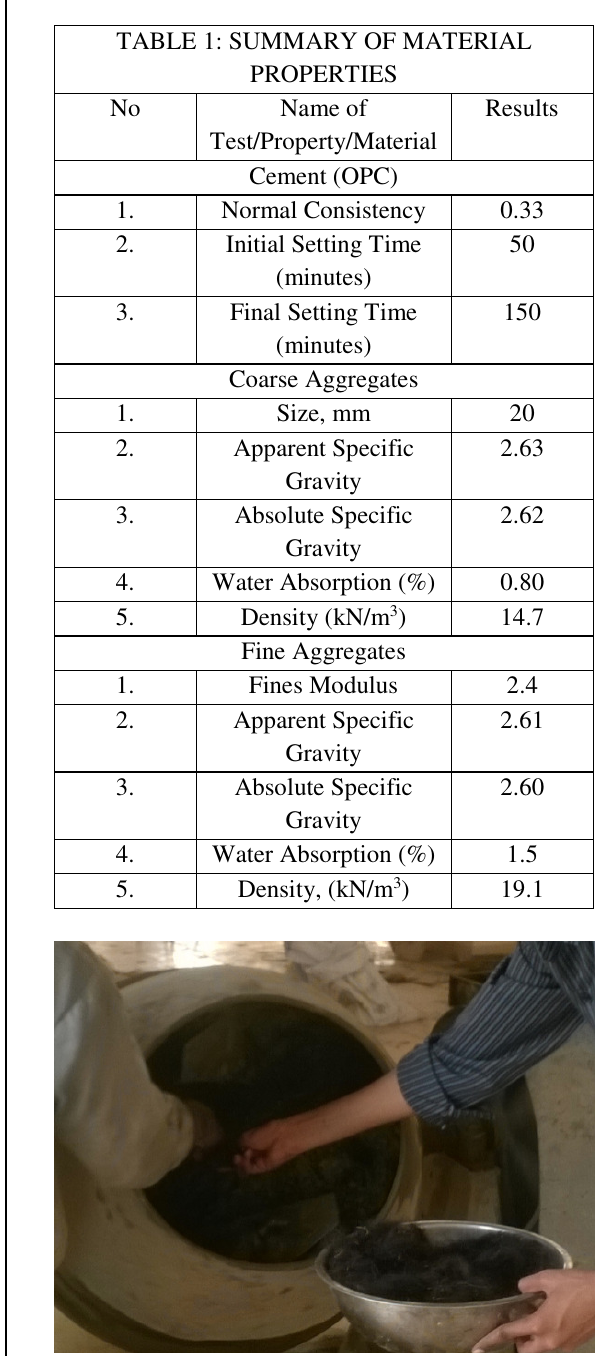
FIG. 1. AN OVERVIEW OF MIXING OF HSH IN